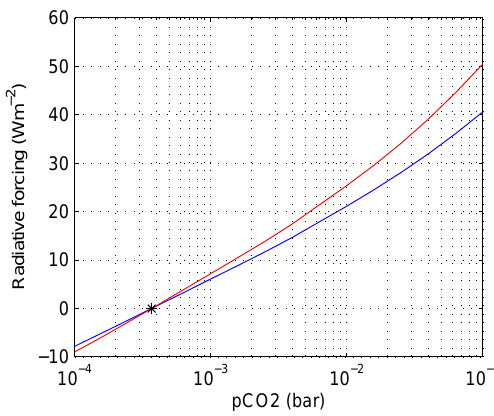
Fig. 7. Radiative forcing with increasing p CO 2 . Real clouds in blue and cloud-free in red. Present p CO 2 marked ( S ).